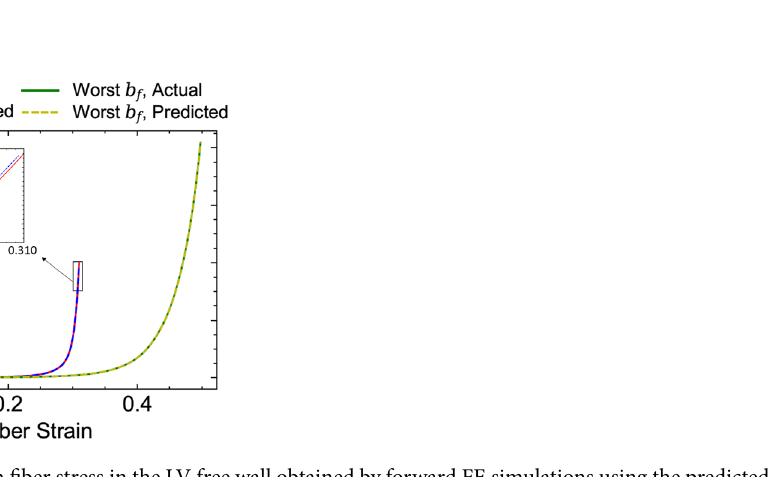
Figure 10. Maximum fiber stress in the LV free wall obtained by forward FE simulations using the predicted properties versus actual properties for the worst predictions listed in Table 3.